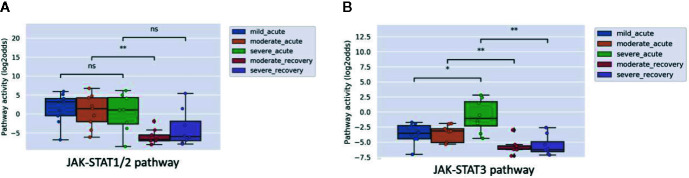
JAK-STAT1/2 (A) and JAK-STAT3 (B) pathway activity analysis of dataset GSE69606 (35) including patients with acute RSV infections, divided into mild, moderate and severe disease. From moderate and severe diseased patients, recovery samples (on average 4 weeks after discharge) were also available. Peripheral blood mononuclear cells (PBMCs) were used for analysis. Pathway activity score on Y-axis in log2odds. Two sided Mann–Whitney–Wilcoxon tests were performed; mild_acute vs servere_acute, moderate_acute vs moderate_revovery and severe_acute vs severe_recovery; p-values are indicated in the figures as *p < 0.05, **p < 0.01, or ns (not significant).